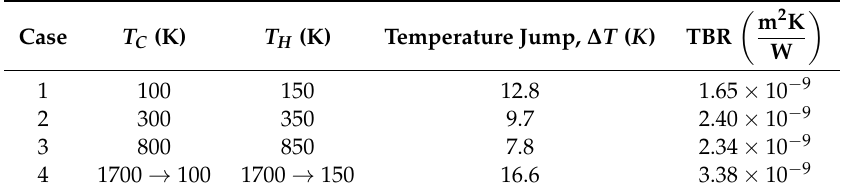
Figure 9. ( a ) zoom of Figure 8b, with the temperature profiles for case 1 ( T H = 150 and T C = 100 K), and case 4 (first heated to 1700 K, and then a steady state at T H = 150 and T C = 100 K). The final molecular structures of the interfaces are given in ( b ) for case 1, and ( c ) for case 4. Table 3. Thermal Boundary Resistance (TBR) of Si/SiO 2 systems, with T C and T H (K) as thermostatted temperature for the heat sink and source